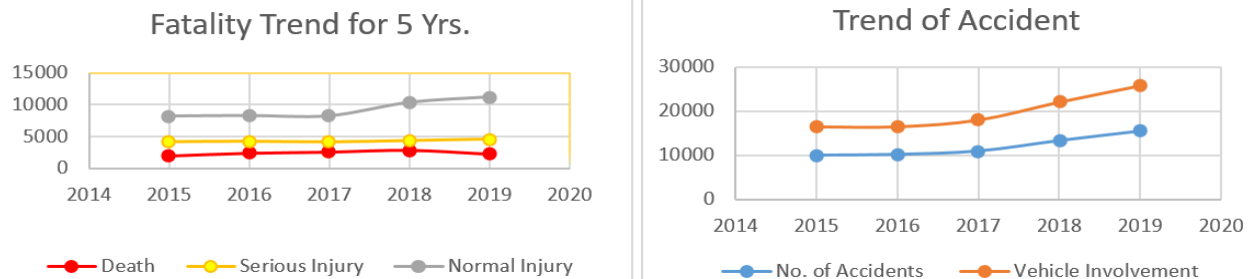
Figure 13: Accident, Vehicle Involvement and road fatality relationship.